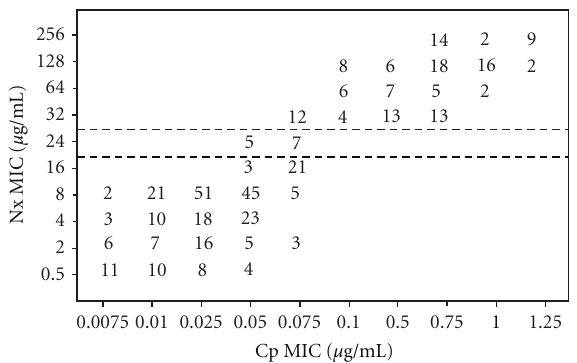
Figure 1: Scattergram for 421 S. Typhi isolates correlating the minimum inhibitory concentration (MIC) values of nalidixic acid (Nx) to the MICs of ciprofloxacin (Cp). The broken horizontal lines represent the NCCLS breakpoint recommendations for suscepti- bility (MIC, ≤ 16 μ g/mL) and resistance (MIC, ≥ 32 μ g/mL) to Nx. The numbers within the graphic indicate the number of S. Typhi